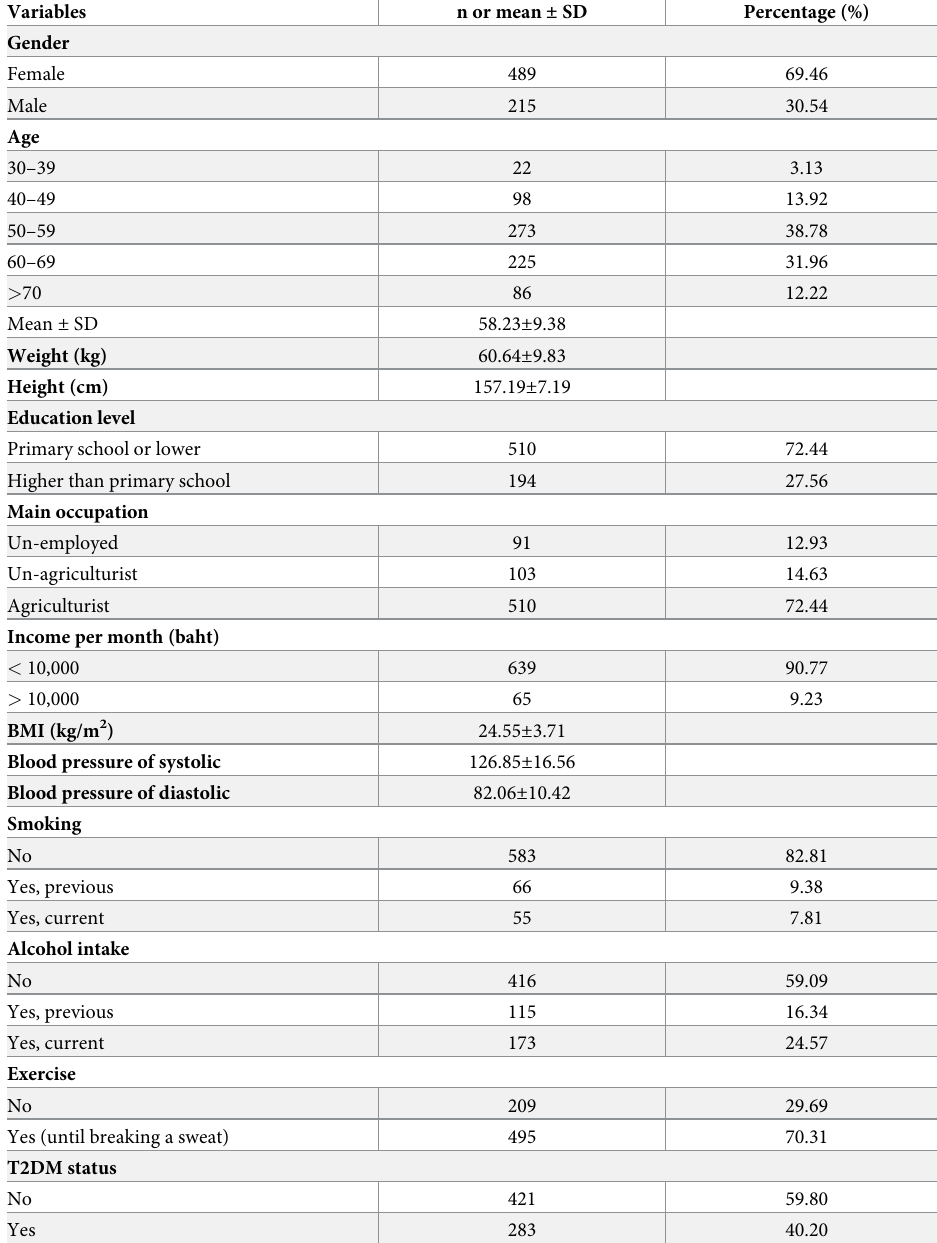
Table 1. Demographic characteristics and socioeconomic status of the population ( n =